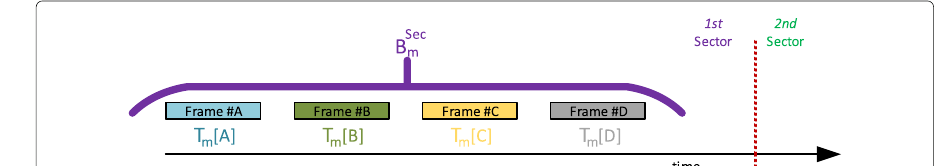
Fig. 7 Sector-based design for the outer